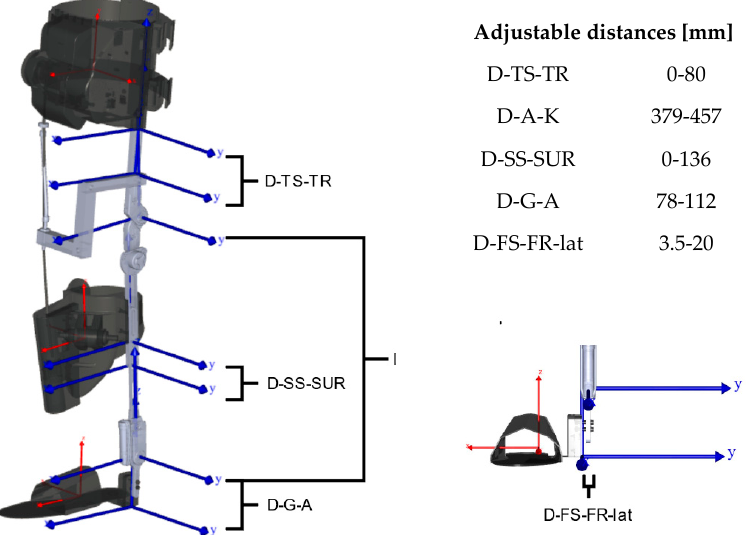
Figure 2. Adjustment possibilities on the eBUS exemplary for the left side ( left ) with a detailed view in the frontal plane ( bottom right ) and the adjustable distances ( top right ) [4]; D-A-K (Distance-Ankle- Knee); D-G-A (Distance-Ground-Ankle); D-TS-TR (Distance-ThighSegment-ThighRail); D-SS-SUR (Distance-ShankSegment-ShankUpperRail); D-FS-FR-lat (Distance-FootSegment-FootRail-lateral).